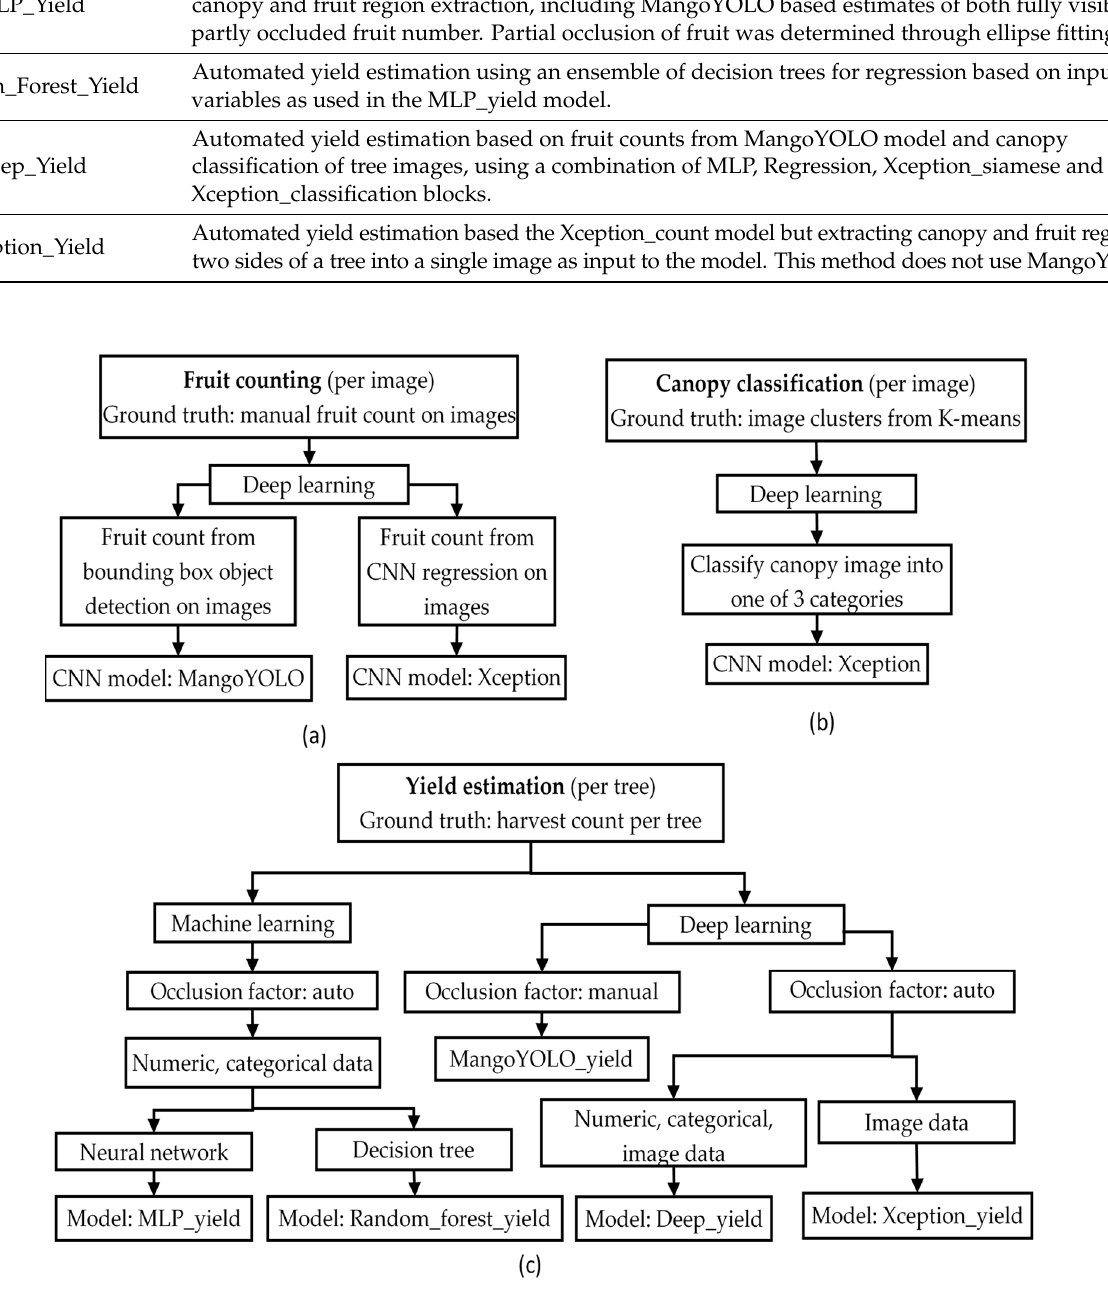
Figure 1. Flowchart of methods used ― for count of fruit in each image ( a ), for canopy classification ( b ) and for yield estimation ( c ).